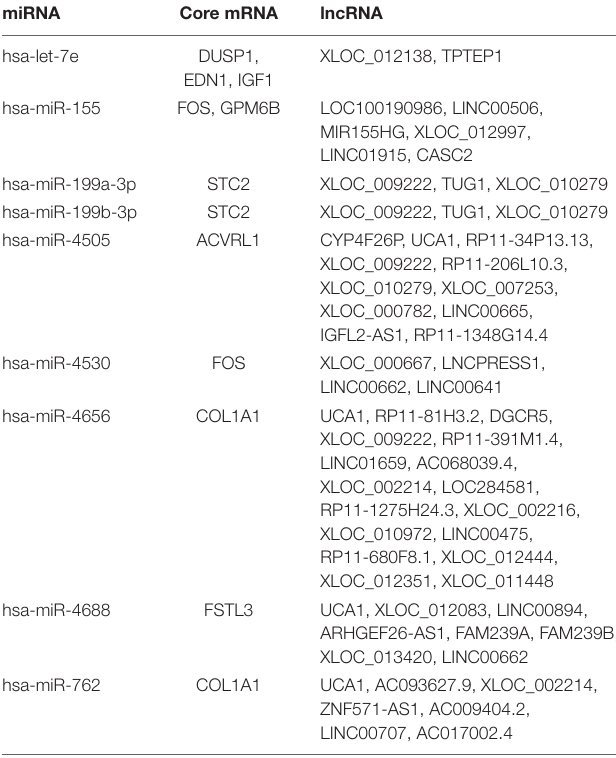
TABLE 2 | The DEmiRs, core mRNAs, and predicted lncRNAs in the ceRNA network. miRNA Core